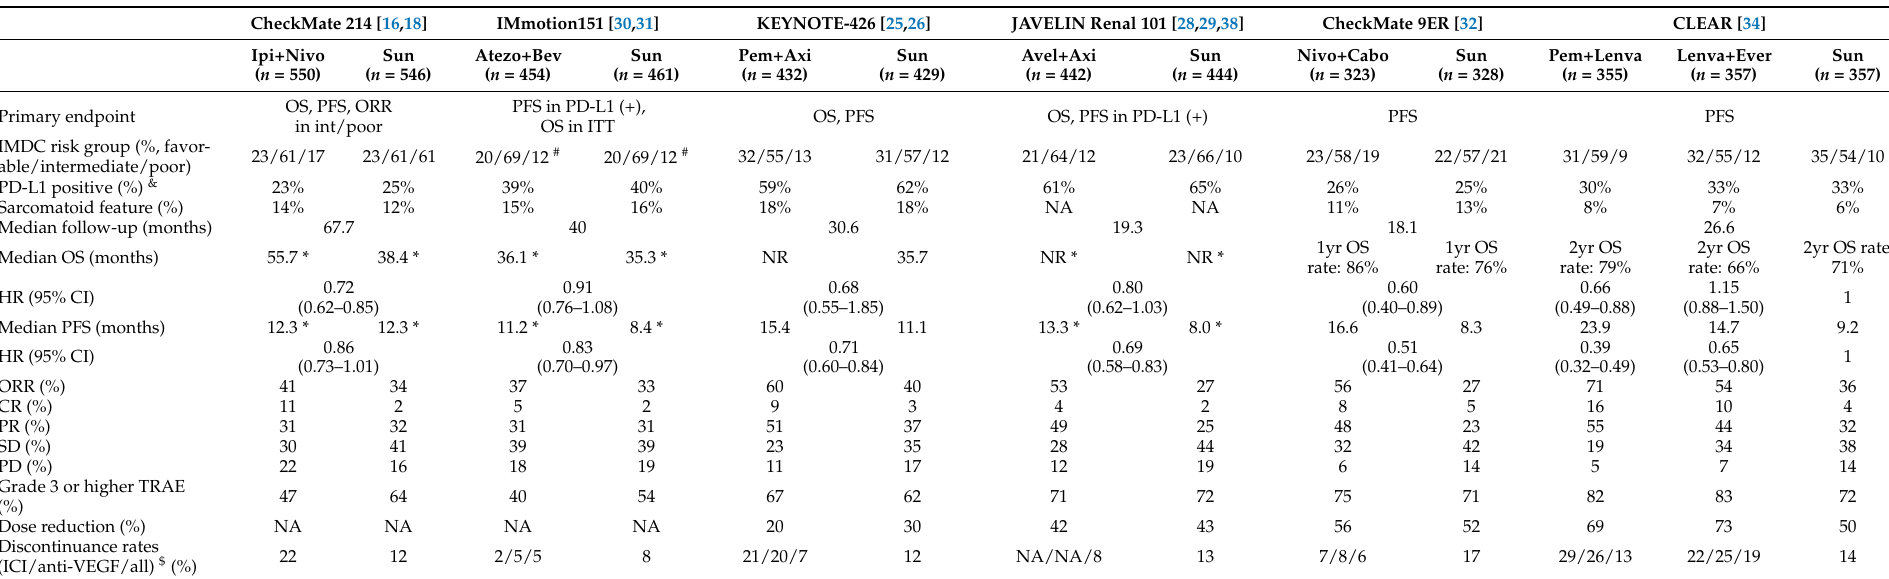
Table 1. Summary of pivotal trials of immune checkpoint inhibitor-based front-line treatments in advanced